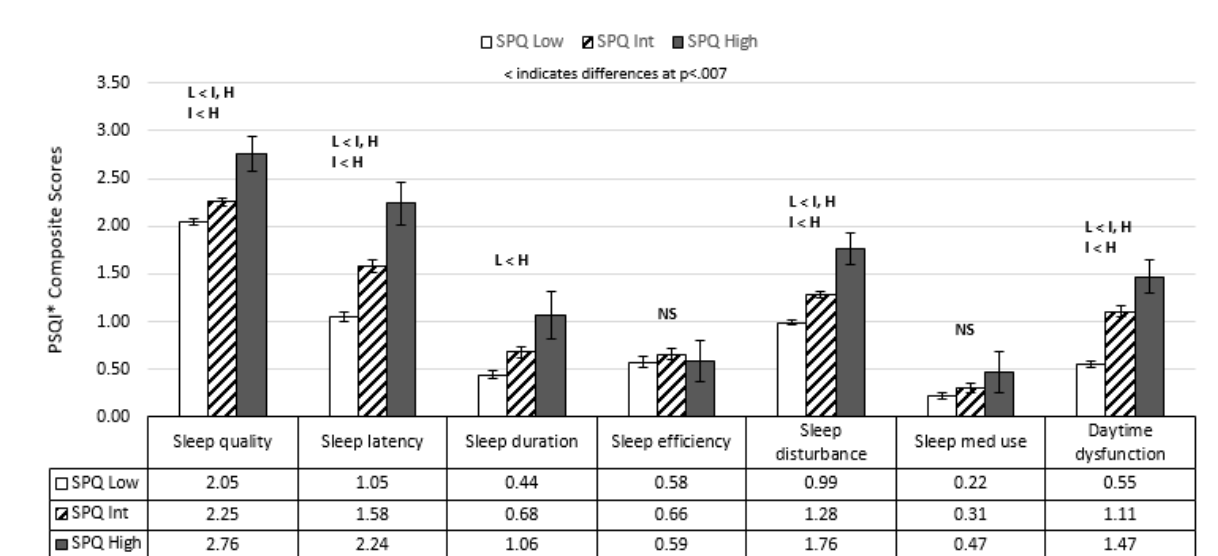
Figure 2. Sleep Quality Comparisons across Low, Intermediate, and High(psychometrically defined) schizotypy catego- ries(Mean/Std. Error). * PSQI = Pittsburgh Sleep Quality Inventory.